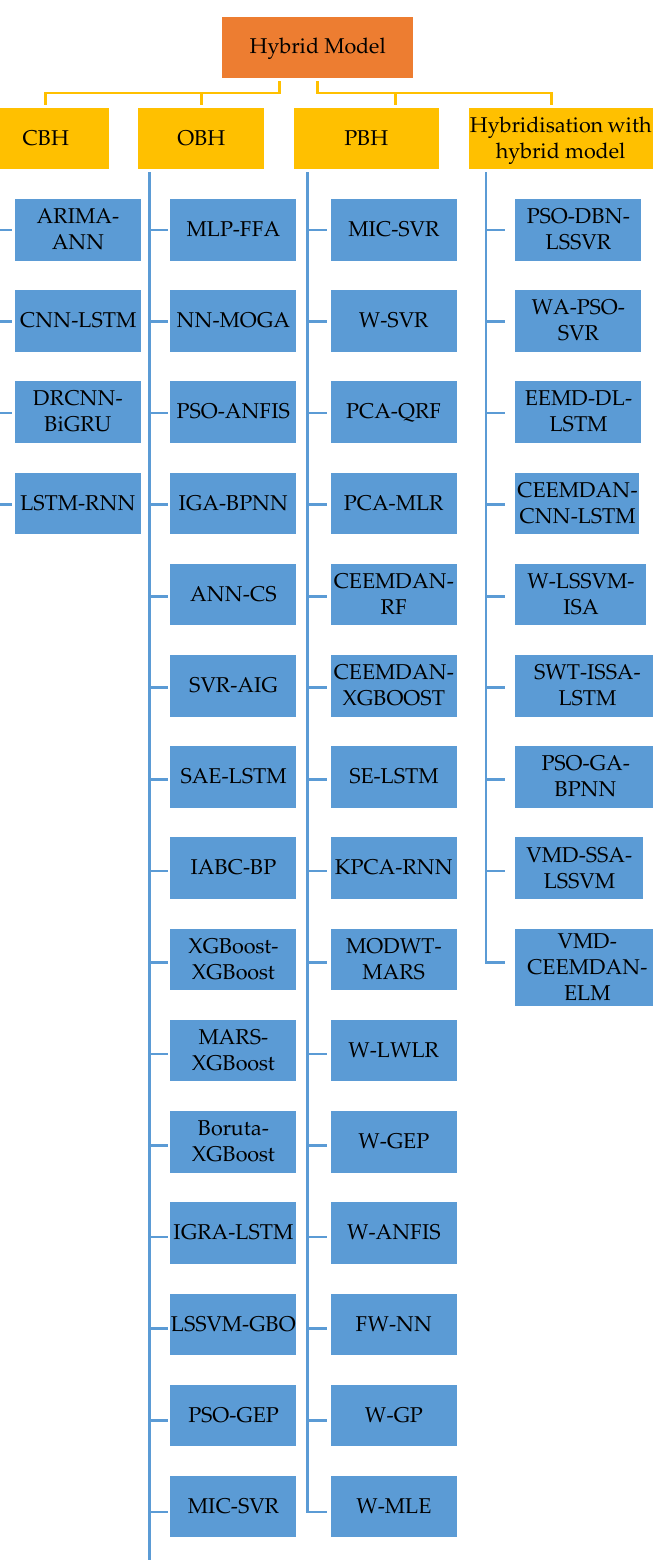
Figure 3. Hierarchy chart to a taxonomy of reviewed hybrid models.